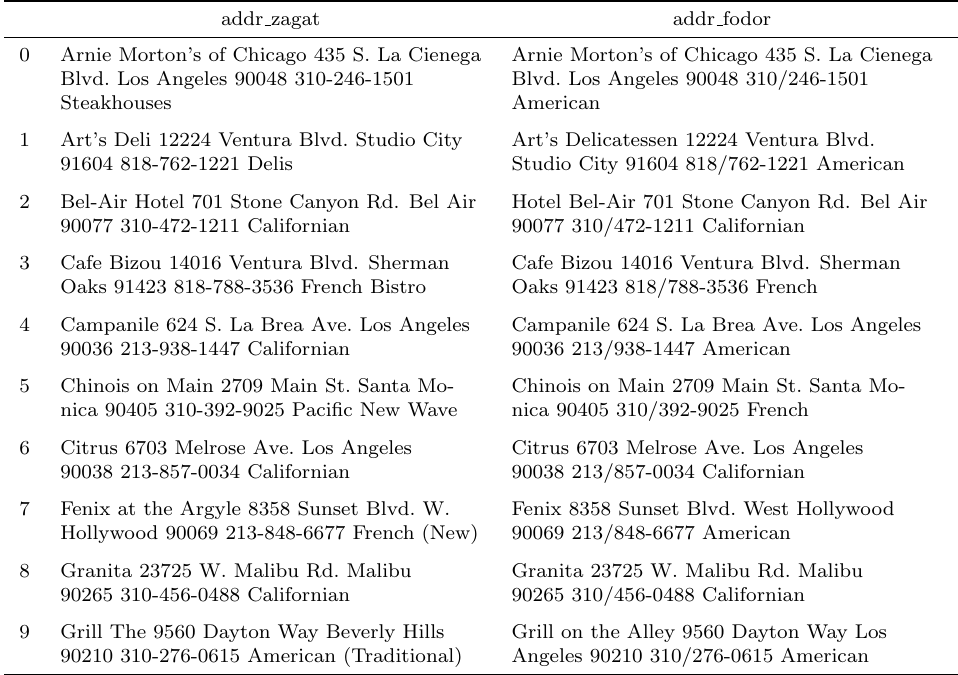
Table 1: Output produced by code